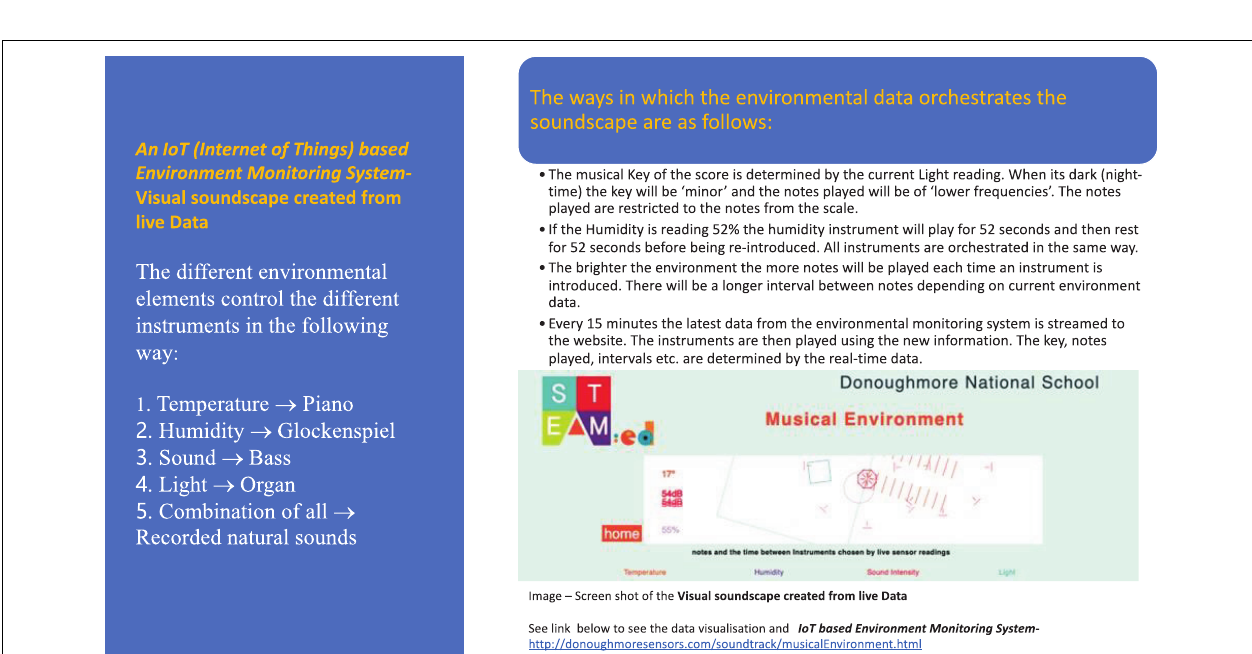
FIGURE 7 | The light data is represented in a line and bar chart, a light intensity map and a radial graph.